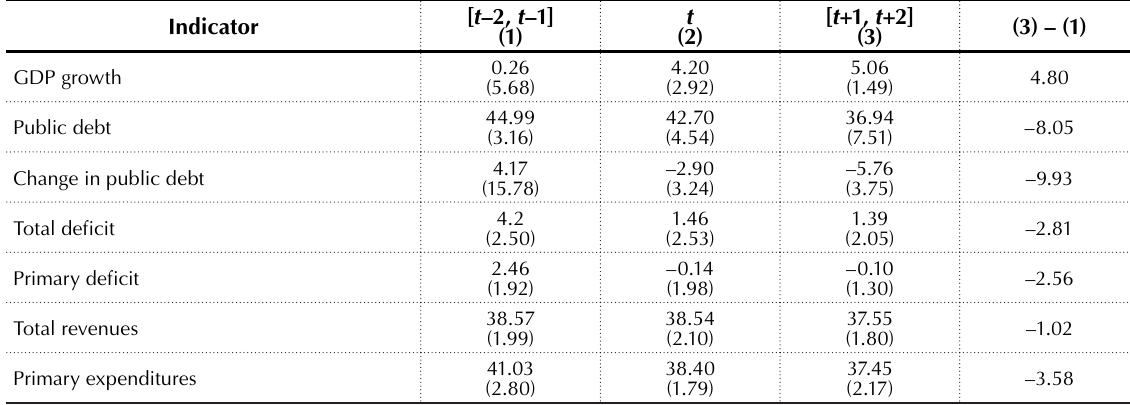
Table 2. Successful fiscal consolidation in the EU countries with emerging market economies: size and